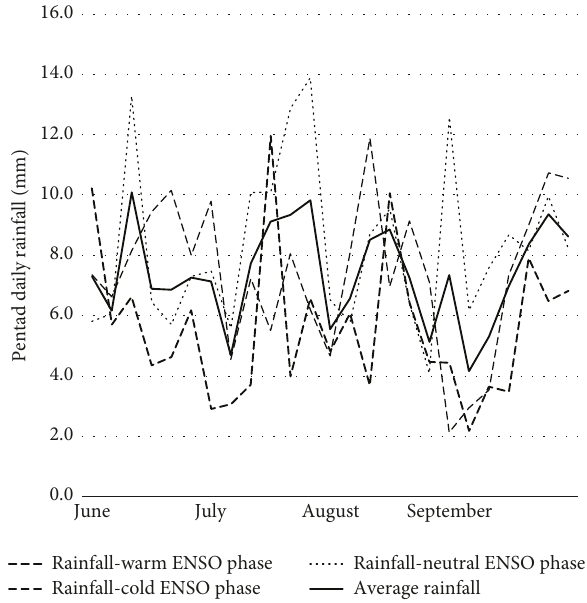
Figure 6: Pentad (five-day mean) rainfall changes in Ambewela station for JJAS season.